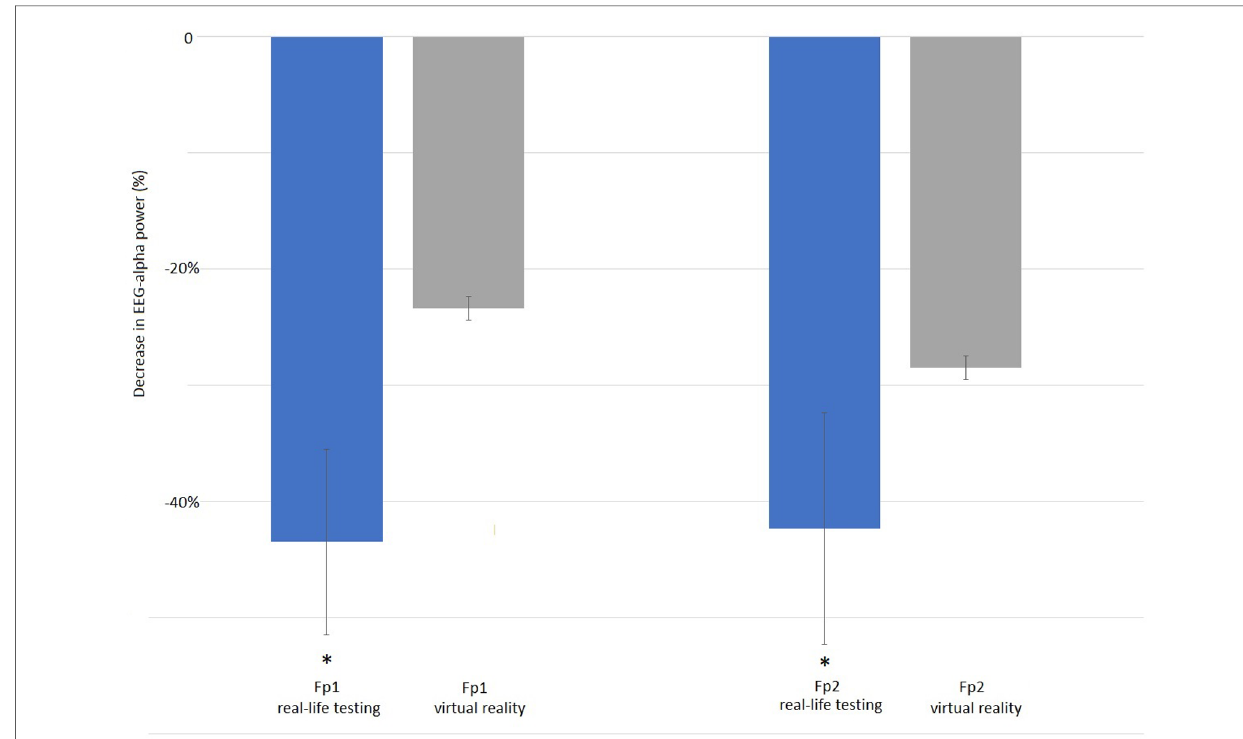
FIGURE 7 Reduction of alpha-band activity at electrode positions Fp1 (left group) and Fp2 (right group): EEG alpha-band activity at 8 Hz is signi fi cantly reduced at position Fp1 by − 43.5% during manually handling the SLS in real-life testing [left blue bar, SD 8, t (6)=10.69, p =0.002] when compared to the automated SLS. Also at position Fp2 the reduction in alpha-band activity is signi fi cant with − 42.35% when testing is done in real-life [SD 10, t (6)=8.74, p =0.003]. During virtual reality testing (grey bars), the decrease in alpha EEG power at positions Fp1 (left grey bar) and Fp2 (right grey bar) is also present with − 23.4% (SD 19) at Fp1 and − 28.5% (SD 16) at Fp2, but does not reach the level of statistical signi fi cance [Fp1: t (7)=4.83, p =0.371], t (7)=3.74, p =0.453).